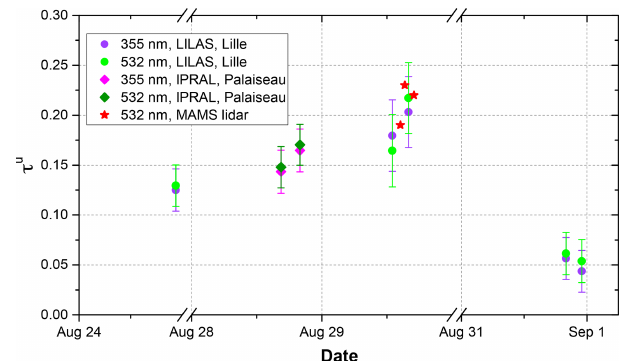
Figure 8. Optical depth of the stratospheric smoke layer at 355 and 532nm estimated from lidar signals in August 2017. The op- tical depth estimated from LILAS (in Lille) is plotted with solid green (532nm) and violet circles (355nm). Optical depth calculated from IPRAL (in Palaiseau) is plotted with solid dark green (532nm) and magenta (355nm) diamonds. The red stars represent the optical depth calculated from the MAMS